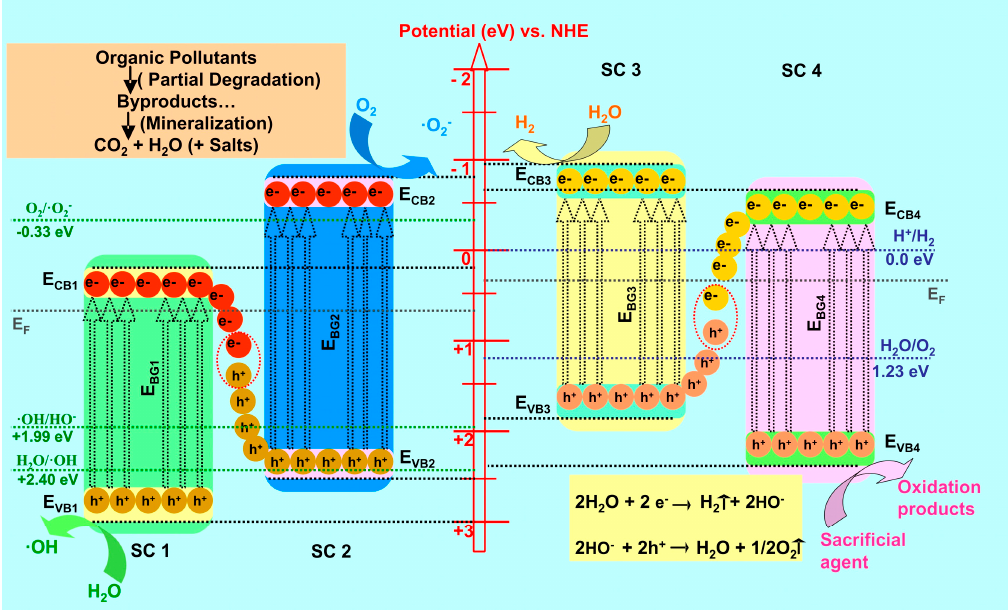
Figure 2. The S-scheme heterostructure mechanism for photocatalytic organic pollutant removal and hydrogen produc- tion.